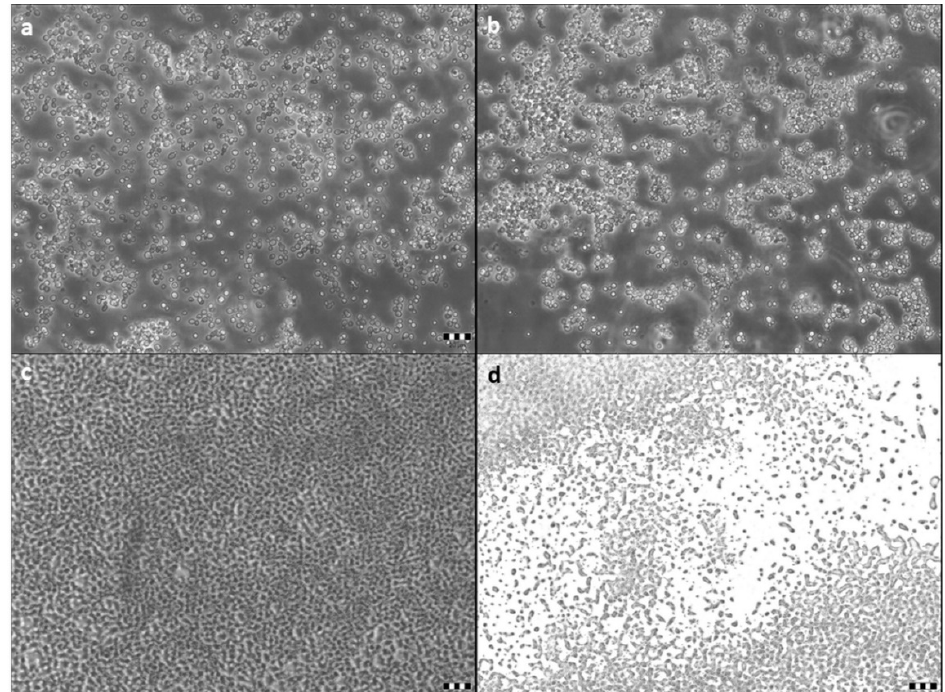
Figure 4. Attachment of microbial cells to glass surface. Yeast cells of W. anomalus cultivated with- out pulcherrimin ( a ) and with pulcherrimin ( b ). Bacterial cells of A. lannensis FMW2 cultivated without pulcherrimin ( c ) and with pulcherrimin ( d ). Bars represent 20 μ m.